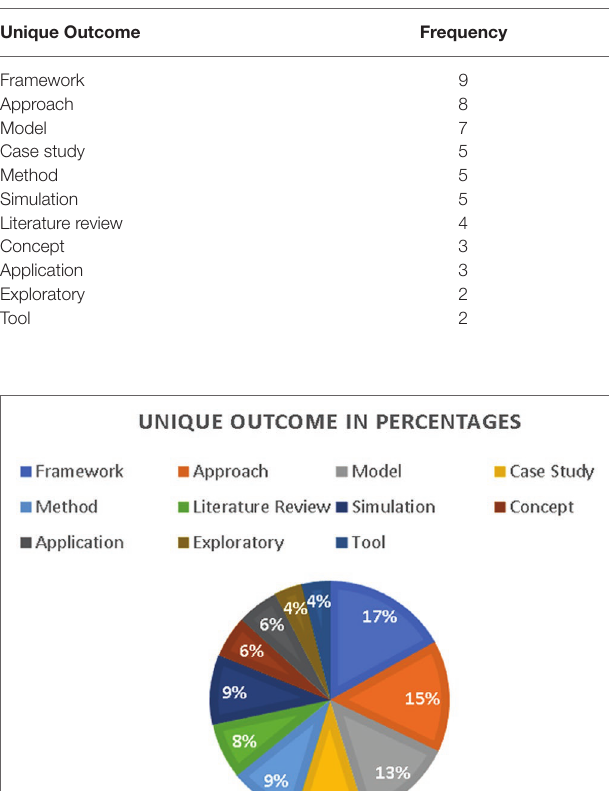
TABLE 4 | Frequency of unique outcomes.